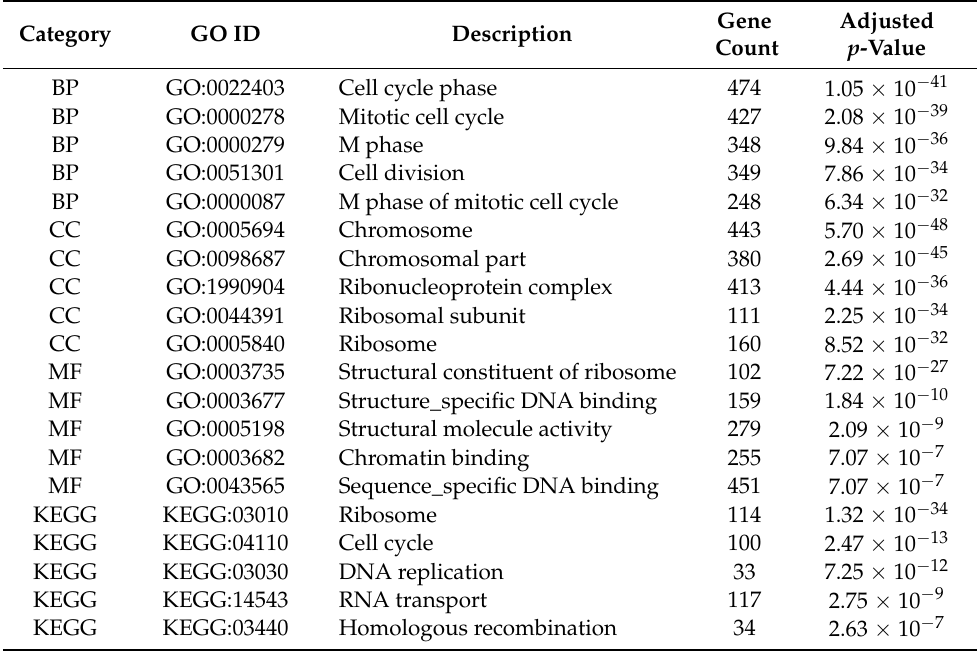
Table 1. Top 5 significantly enriched GO terms and KEGG pathways of DEGs.